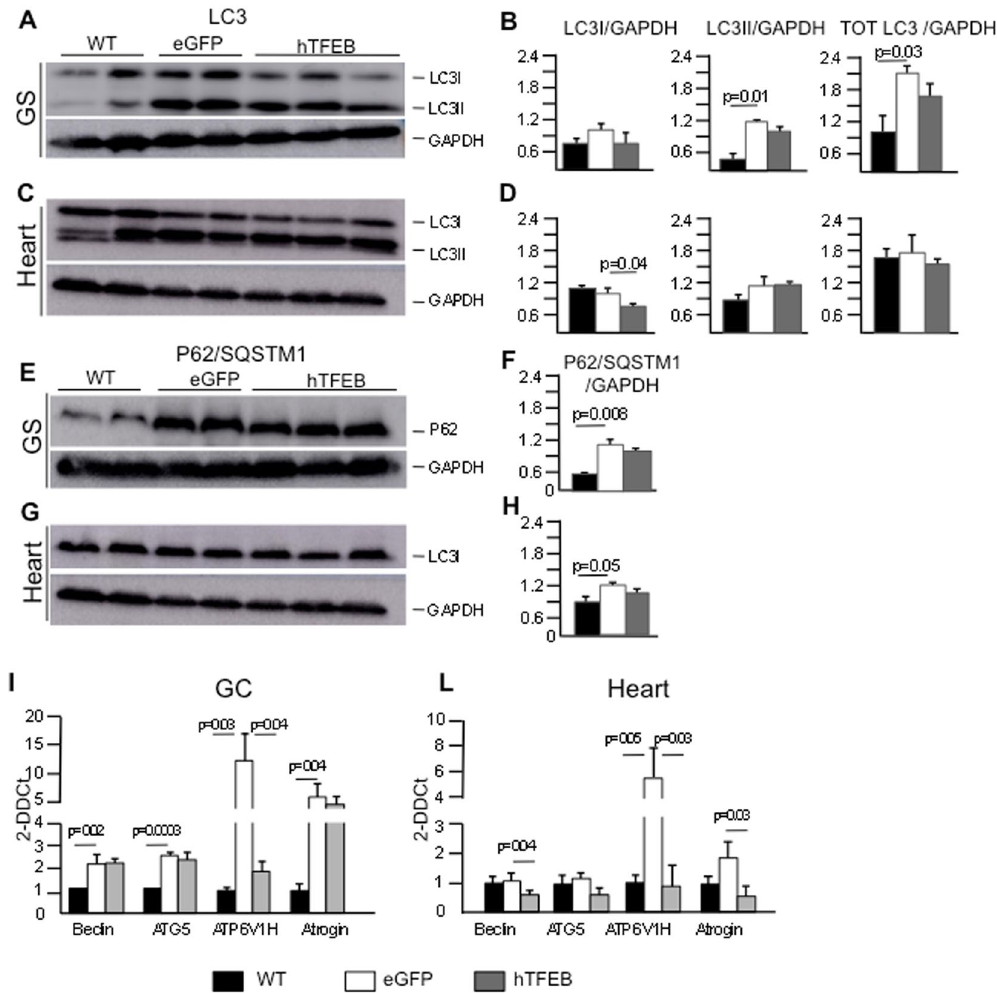
Figure 3. Evaluation of autophagy-related and atrophy markers. Western blot analysis of LC3I/II ( A – D ) and P62/SQSTM1 ( E – H ) in muscles (gastrocnemius and heart) from 3-mo-old WT, eGFP-treated and TFEB treated mice. GAPDH was used as a loading control. The blots were cropped eliminating, for clarity, lanes that were not relevant for the results shown; in the blots contrast was enhanced electronically (and not overexposed). Full-length blots are presented in Supplementary Fig. S3. Graphical representation of relative intensity data are shown in the graph as mean ± SEM. mRNA transcript abundance of autophagy-related and atrophy genes was assessed by RT-PCR ( I – L ). Values are represented as RNA fold change and show means ± SEM. The data are analyzed using one-tailed Student’s